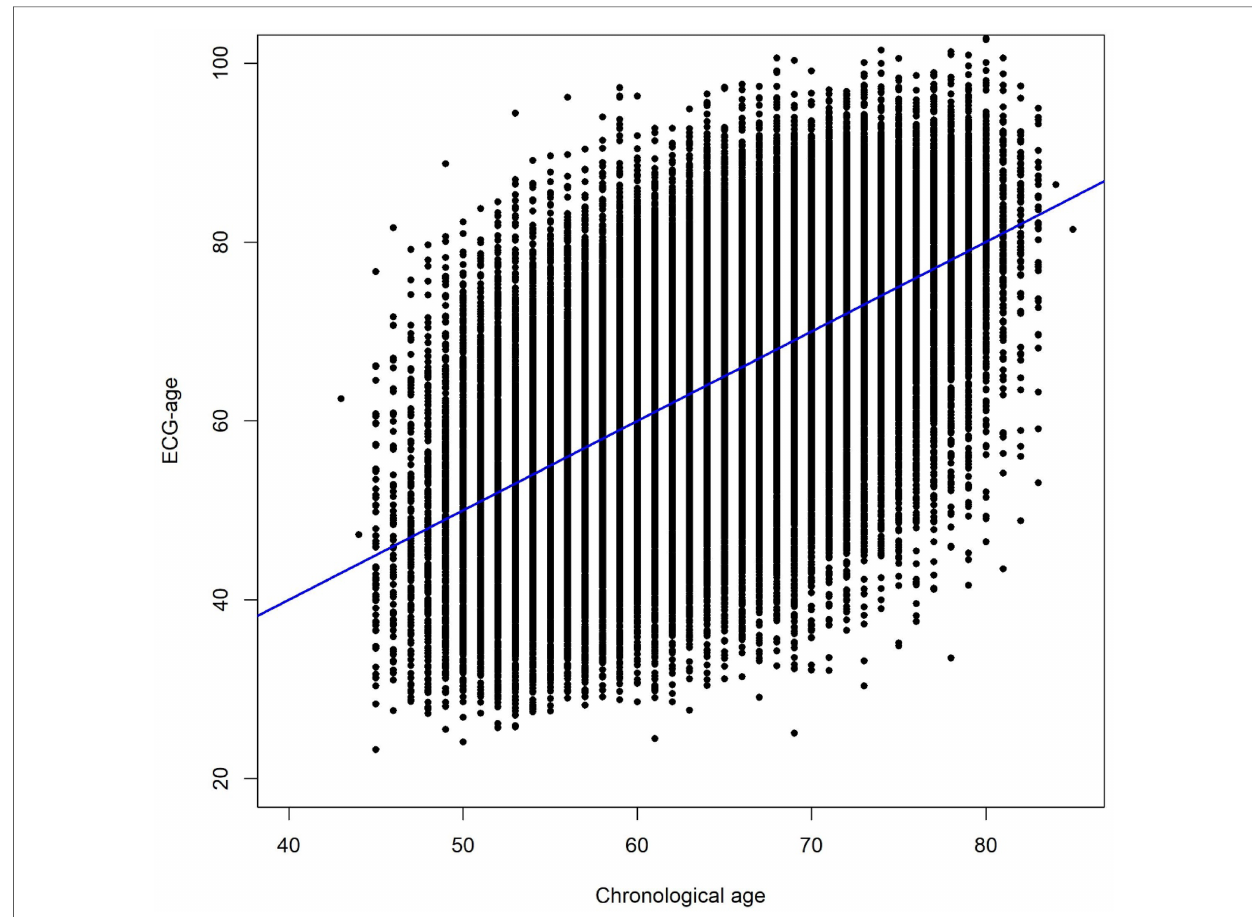
FIGURE 3 Distribution of healthy lifestyle scores among participants. Each point represents the adherence of one healthy lifestyle factor.